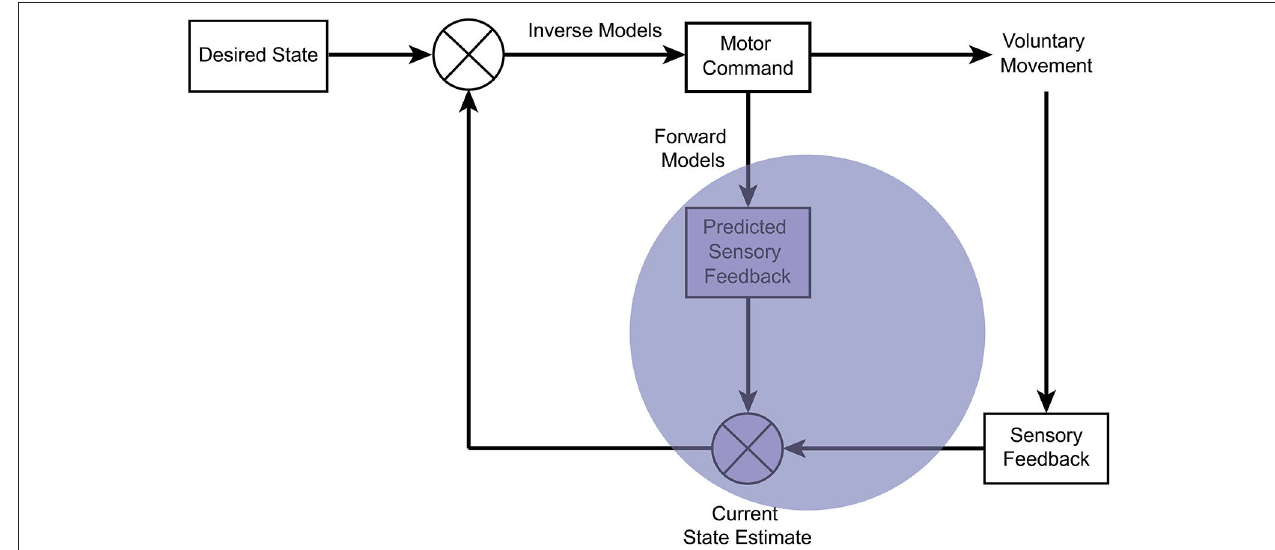
used by forward models to predict the sensory effect. The predicted sensory effect is compared and integrated with the actual sensory feedback from the moving body part to generate an optimal state estimate. According to the comparator model, the sense of agency arises from the comparison between the predicted and actual sensory feedback (opaque blue). When the discrepancy is small, the sensory effect is attributed to one’s own volition, but when the discrepancy is large, the sensory effect is interpreted as externally